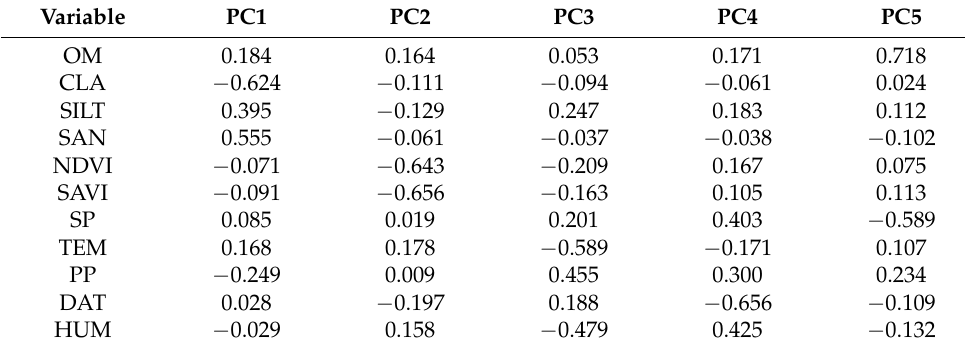
Table 3. Eigen values of selected principal